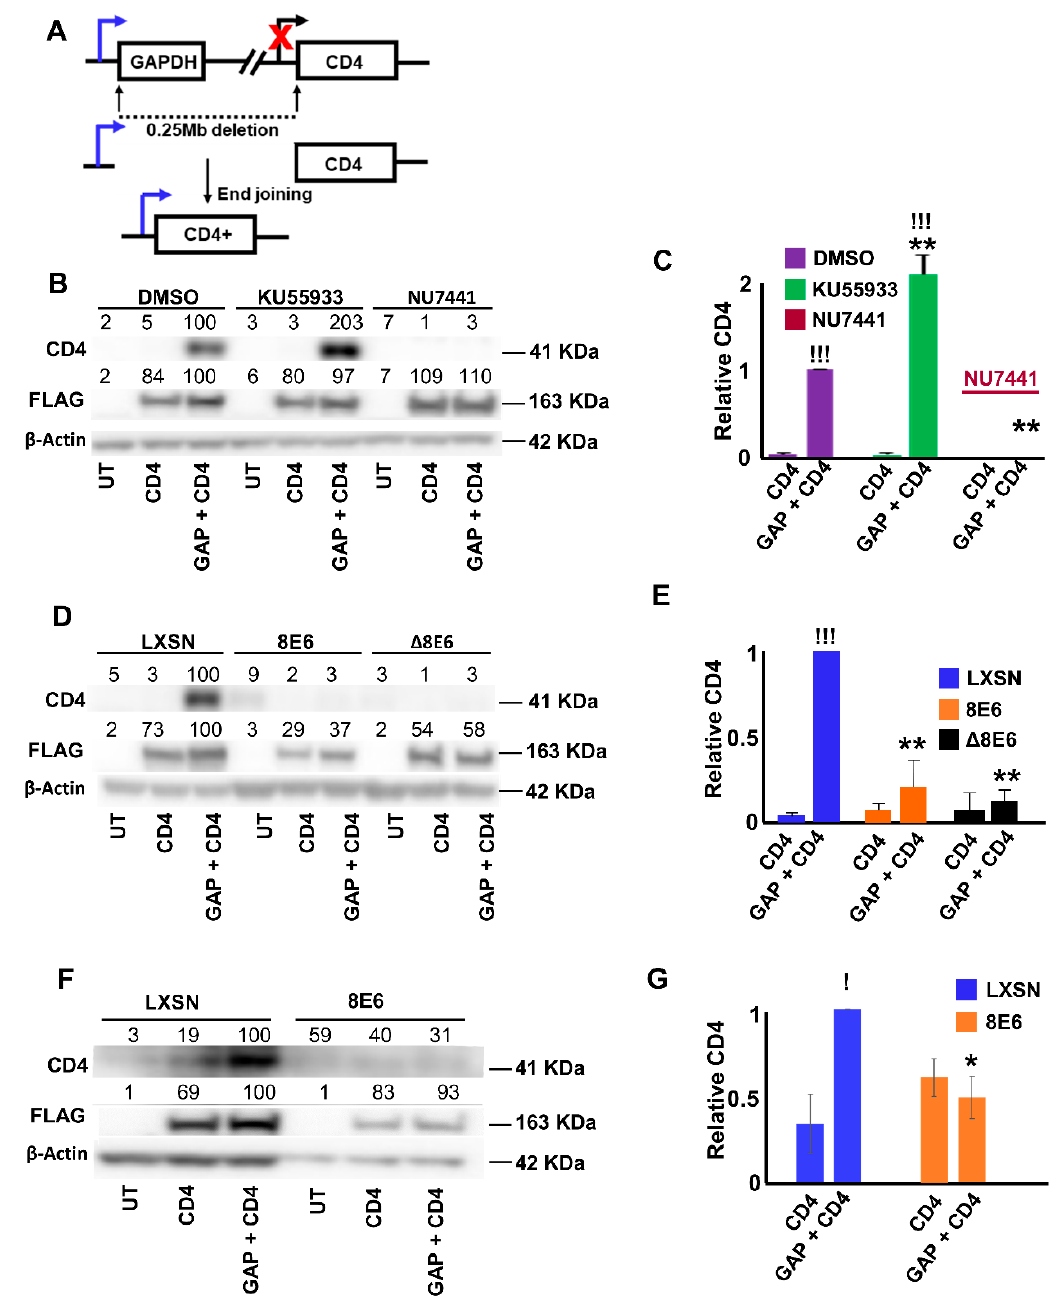
Figure 1. Moreover, beta-human papillomavirus ( β -HPV) 8E6 decreases non-homologous end joining (NHEJ) efficiency, using CD4 expression as a readout. ( A ) Schematic of end-joining reporter assay. FLAG-tagged SgRNA-CAS9 induced double strand breaks in GAPDH and CD4 on chromosome 12 in U2OS cells. Rearrangement leads to CD4 expression driven by the promoter of GAPDH. Red “X” represents that CD4 expression is naturally inactivated. ( B ) Representative immunoblots showing CD4 expression in U2OS cells treated with control, ATM inhibitor (KU55933), and DNA-PK inhibitor (NU7441), after transfection with control (UT), FLAG-tagged SgRNA-CAS9 targeting CD4 (CD4), and FLAG-tagged SgRNA-CAS9 targeting GAPDH together with FLAG-tagged SgRNA-CAS9 targeting CD4 (GAP / CD4). ( C ) Densitometry of immunoblots ( n = 3) from panel B. CD4 was normalized to β -actin as a loading control. Transfection efficiency was accounted for using FLAG abundance. ( D ) Representative immunoblots showing CD4 expression in U2OS LXSN, β -HPV 8 E6, and β -HPV ∆ 8E6 after transfection with control (UT), FLAG-tagged SgRNA-CAS9 targeting CD4 (CD4), and FLAG-tagged SgRNA-CAS9 targeting GAPDH and FLAG-tagged SgRNA-CAS9 targeting CD4 (GAP/CD4). ( E ) Densitometry of immunoblots ( n = 3) from panel D. CD4 was normalized to β -actin as a loading